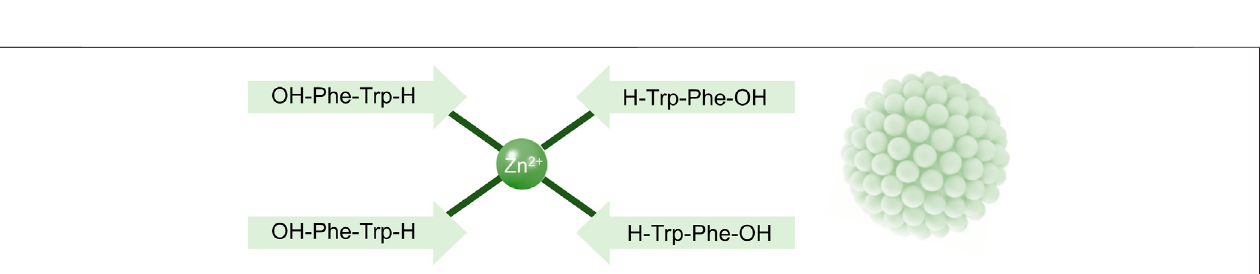
Frontiers in Materials |